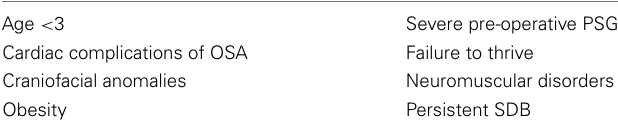
Table 2 | Indications for post-operative PSG